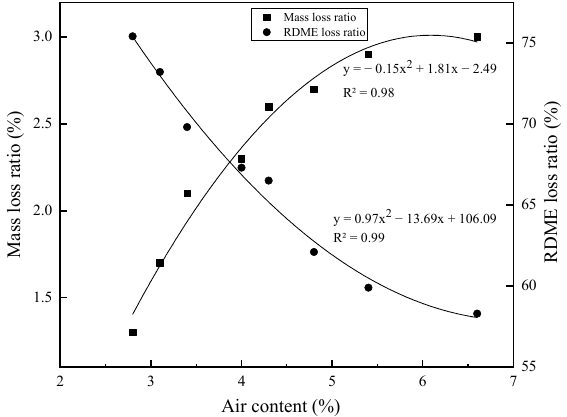
Figure 12. Relationship between air content and frost resistance.